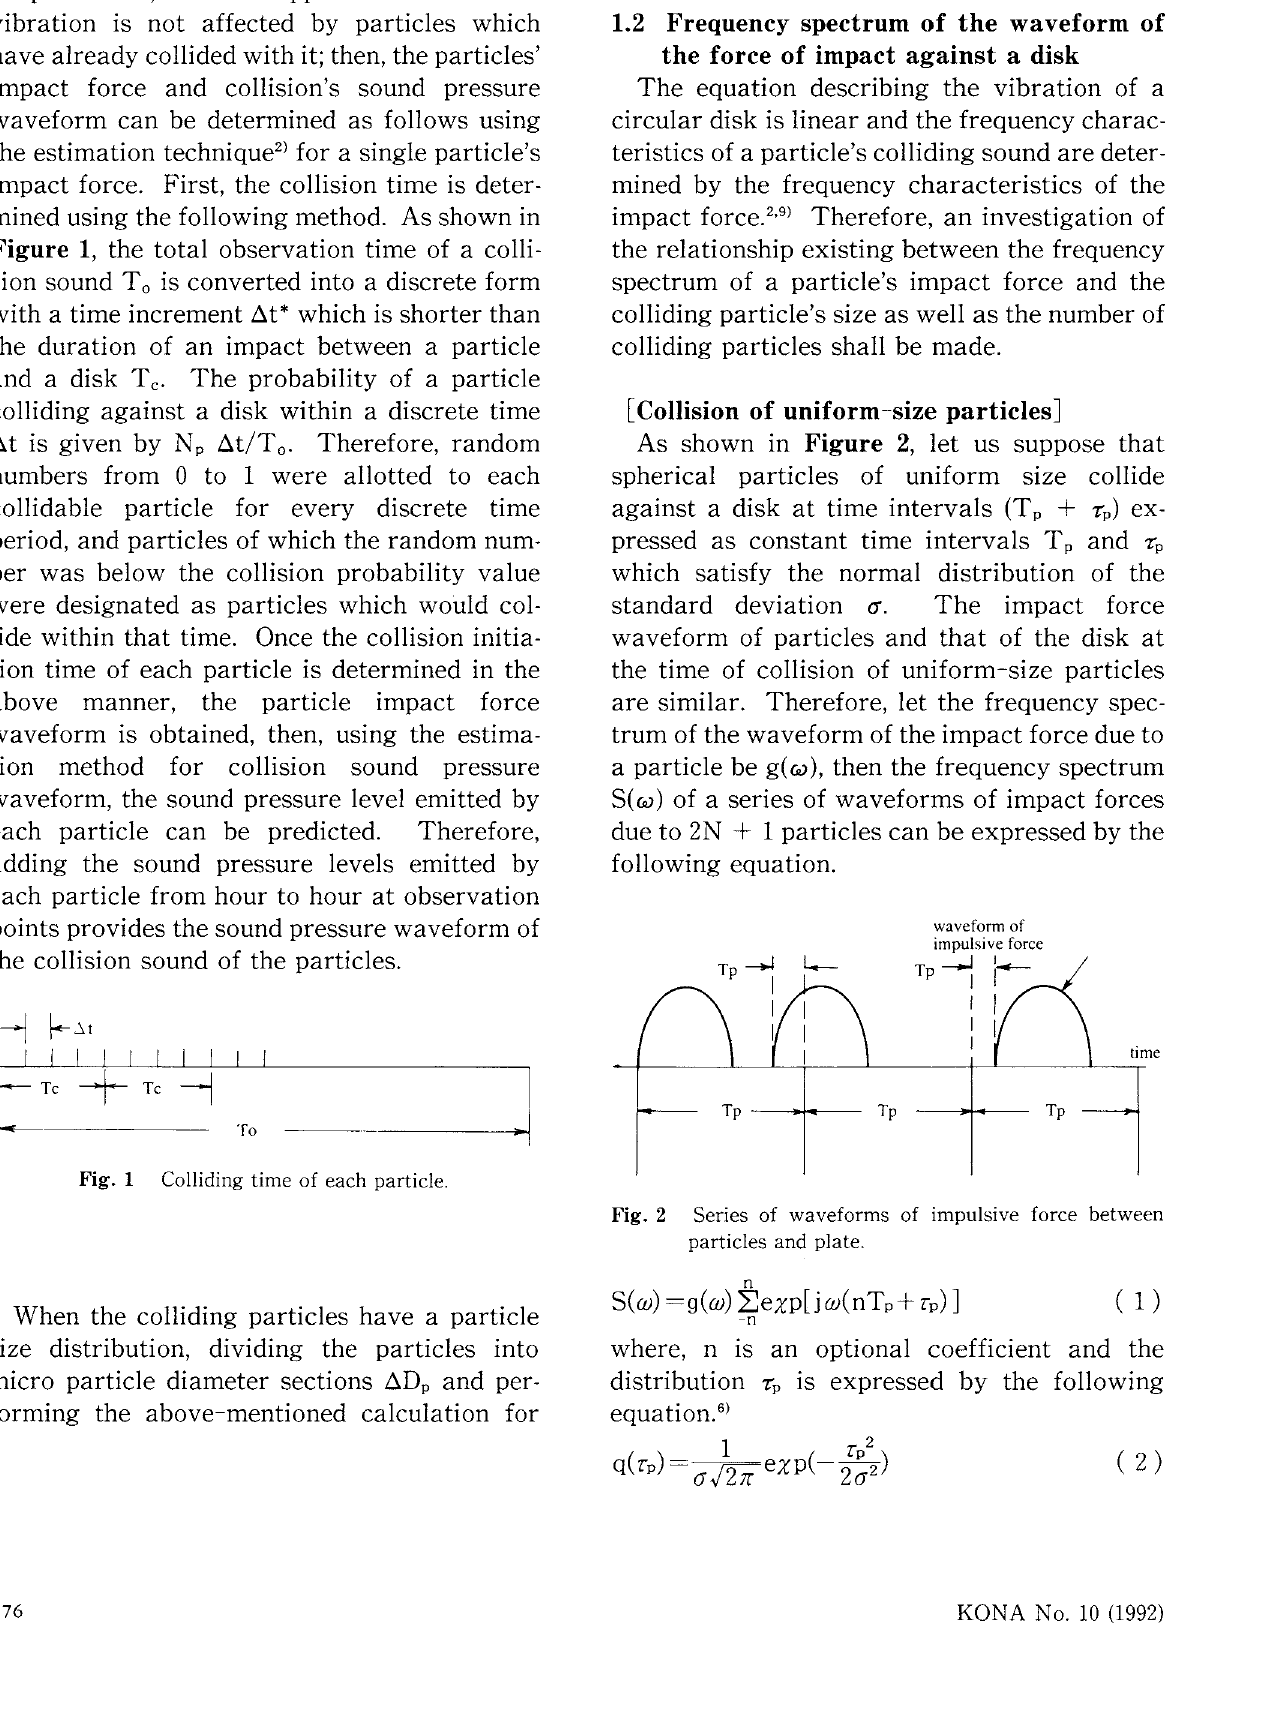
Fig. 1 Colliding time of each particle.